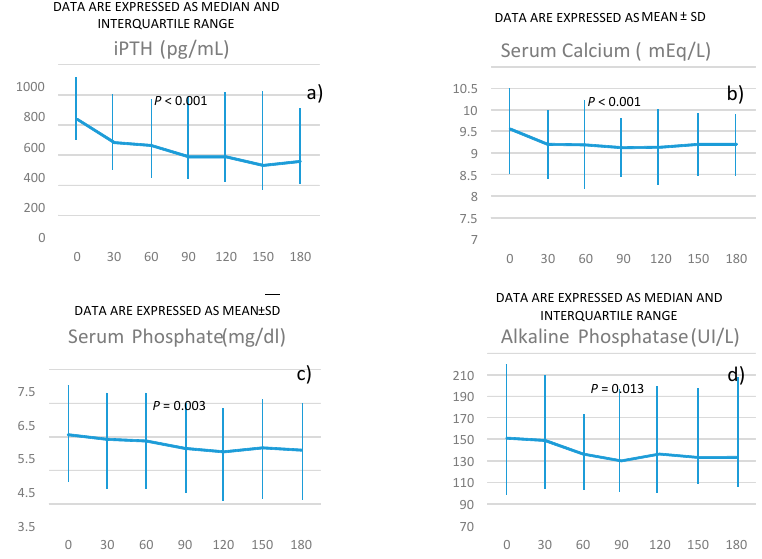
Figure 1. P for the trend of intact parathyroid hormone (iPTH) (panel a ), serum calcium (panel b ), serum phosphate (panel c ), alkaline phosphatase (panel d ) over time was obtained using linear regression models weighted for patients’ identification (see methods for more details).